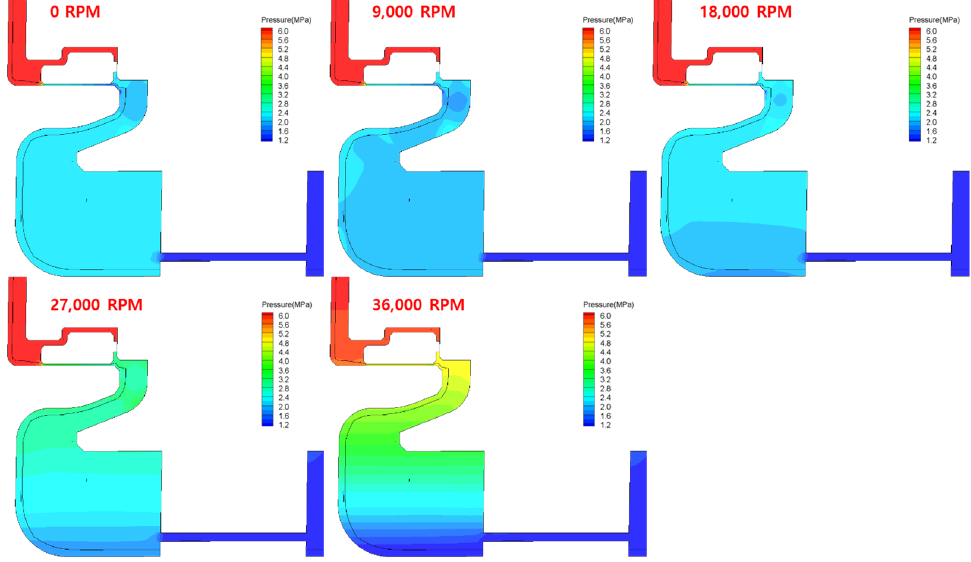
Figure 10. Static pressure (MPa) distributions with rotating speed variation.